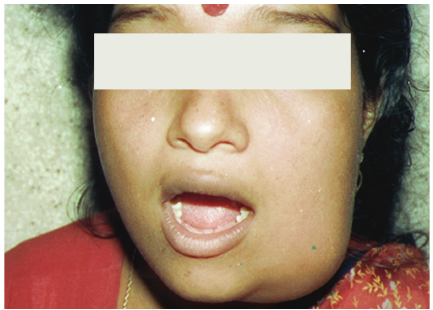
Figure 3: Lateral oblique view of the mandible showing the extent of the tumor.